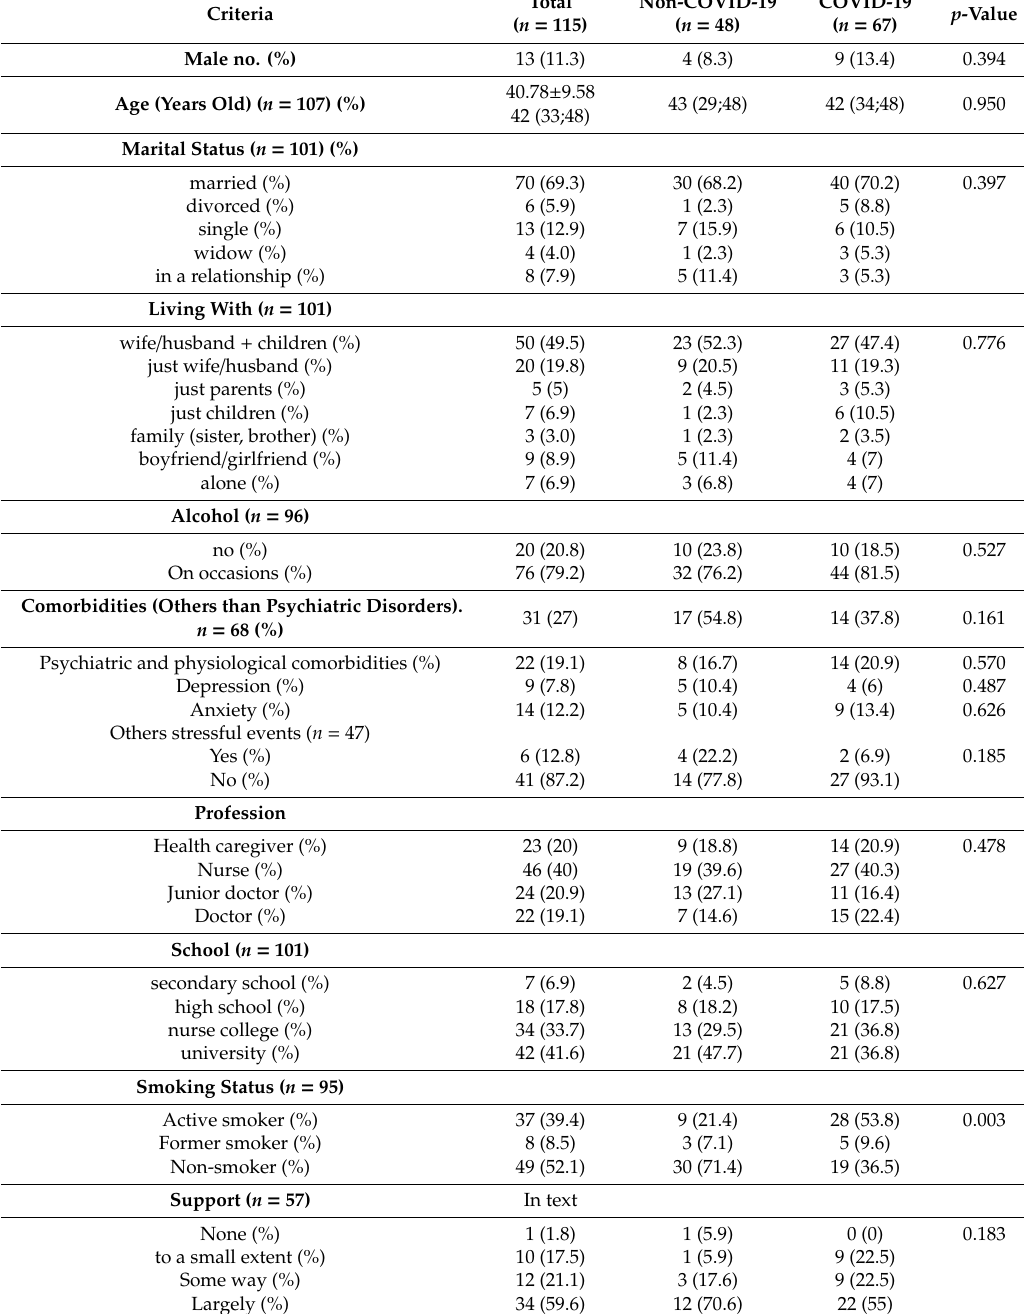
Table 1. Participant